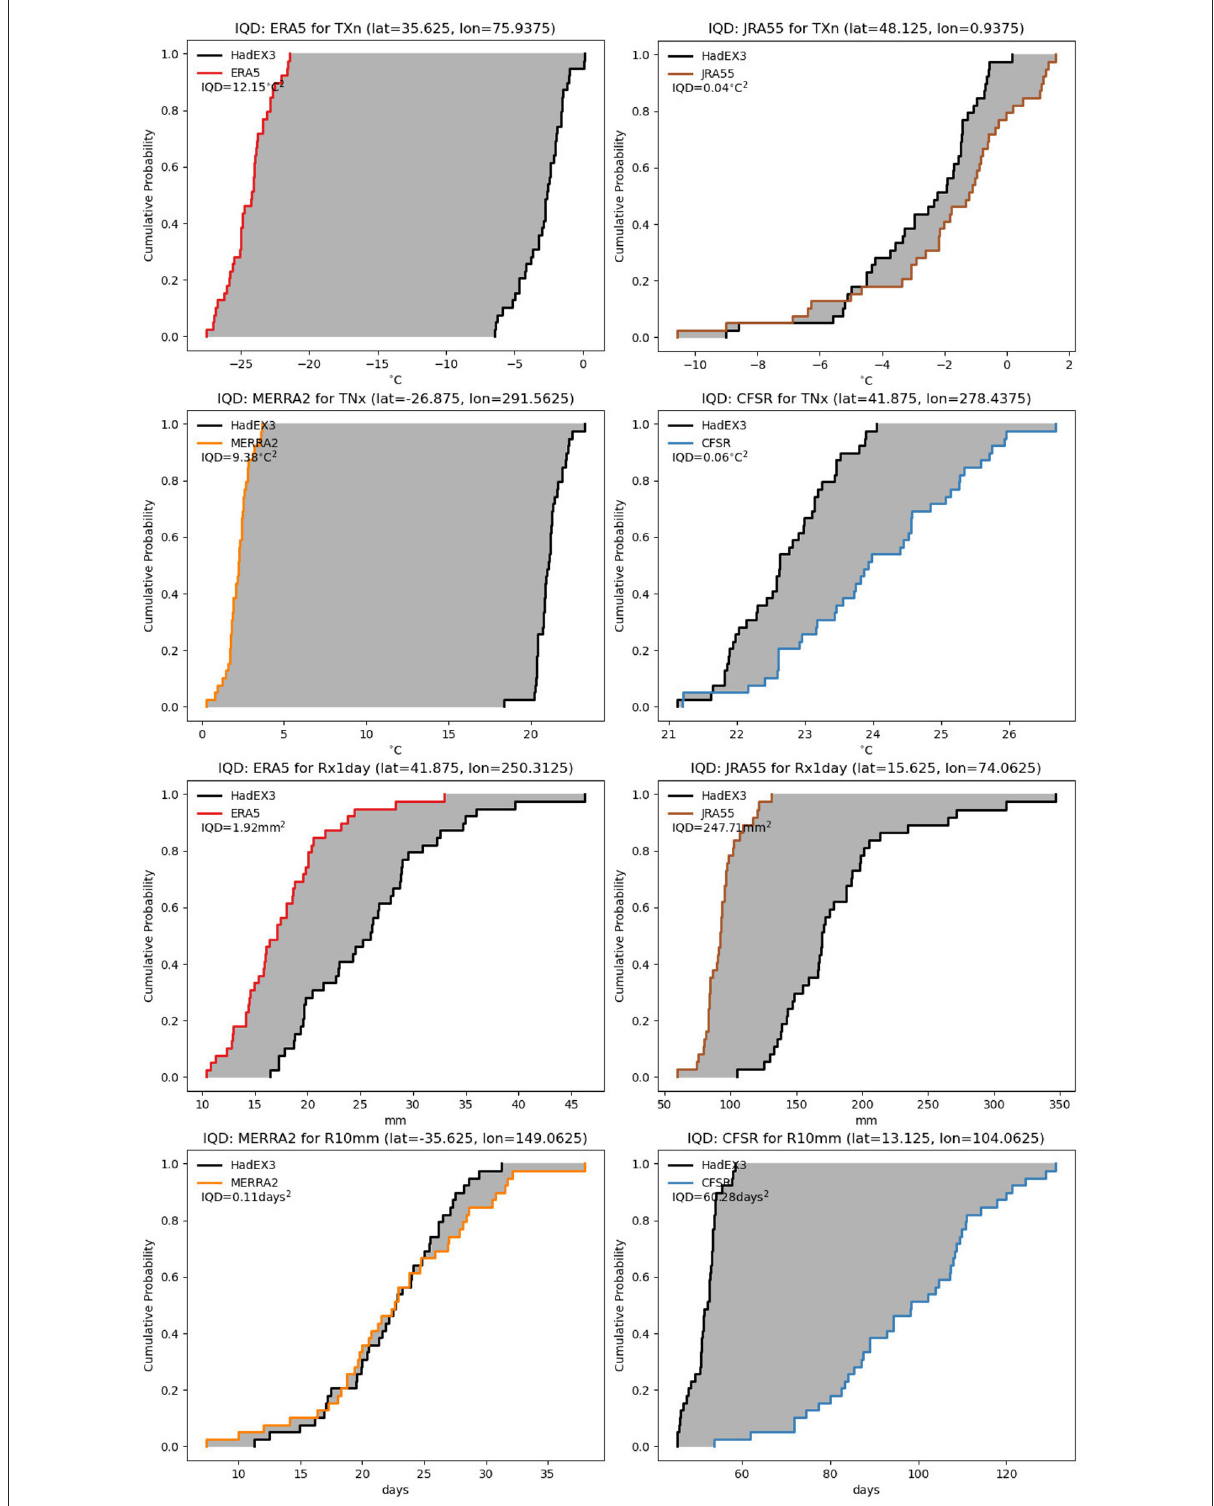
FIGUREA2 Cumulative probability distributions for HadEX3 and four selected reanalyses for selected individual grid boxes, showing the area defined by the IQD measure. The rows show TXn, TNx, Rx1day, and R10mm, respectively.